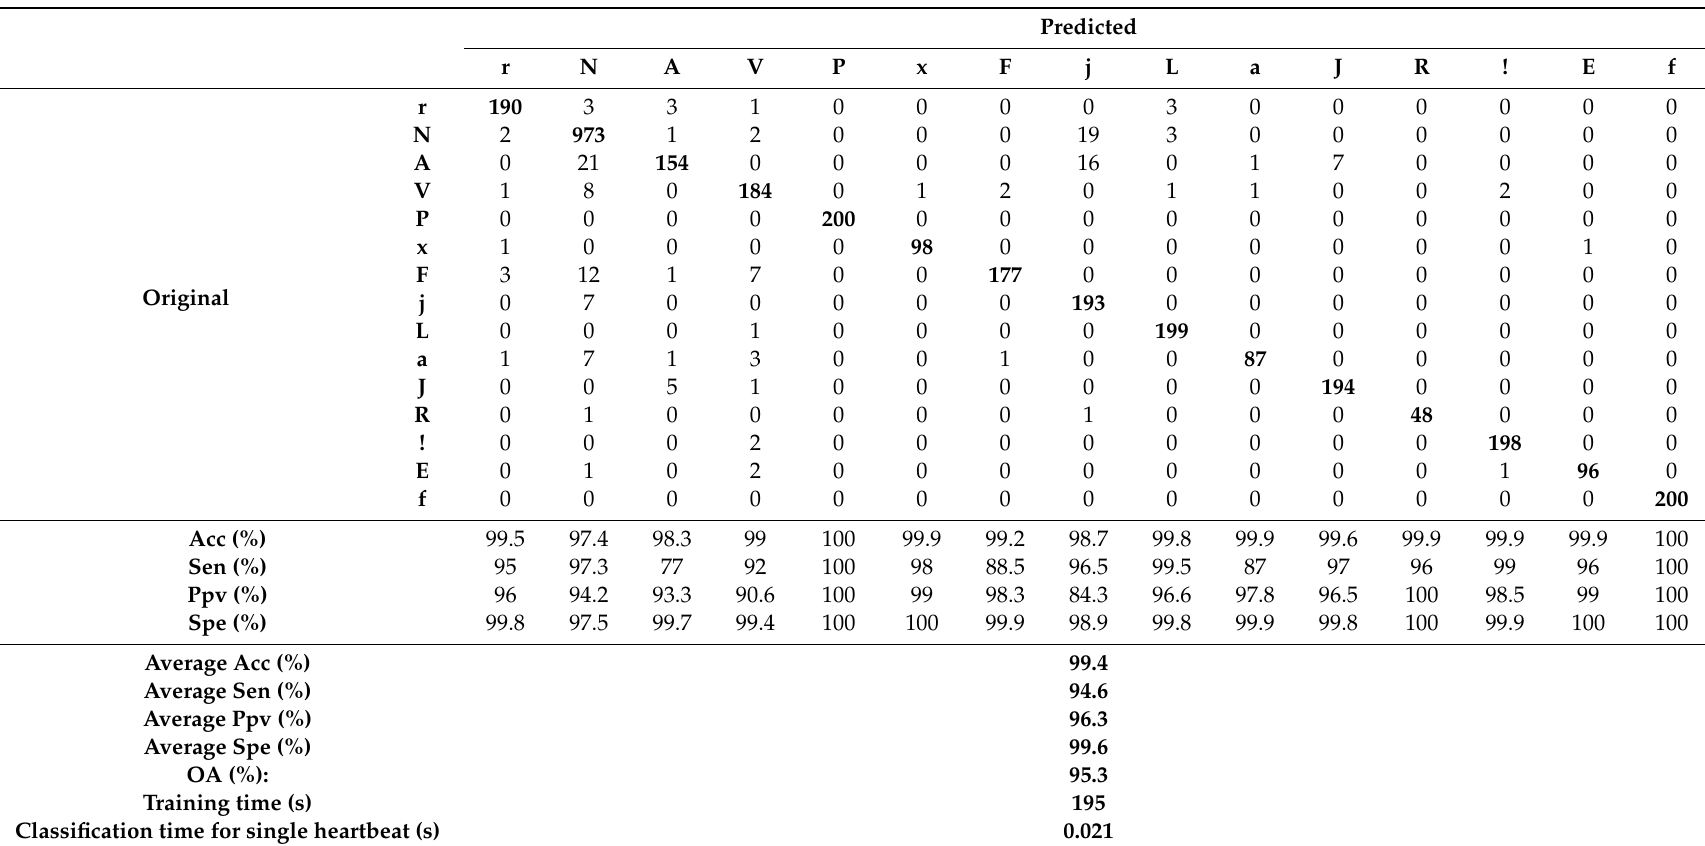
Table 10. Confusion matrix obtained using II and V5 leads across 10